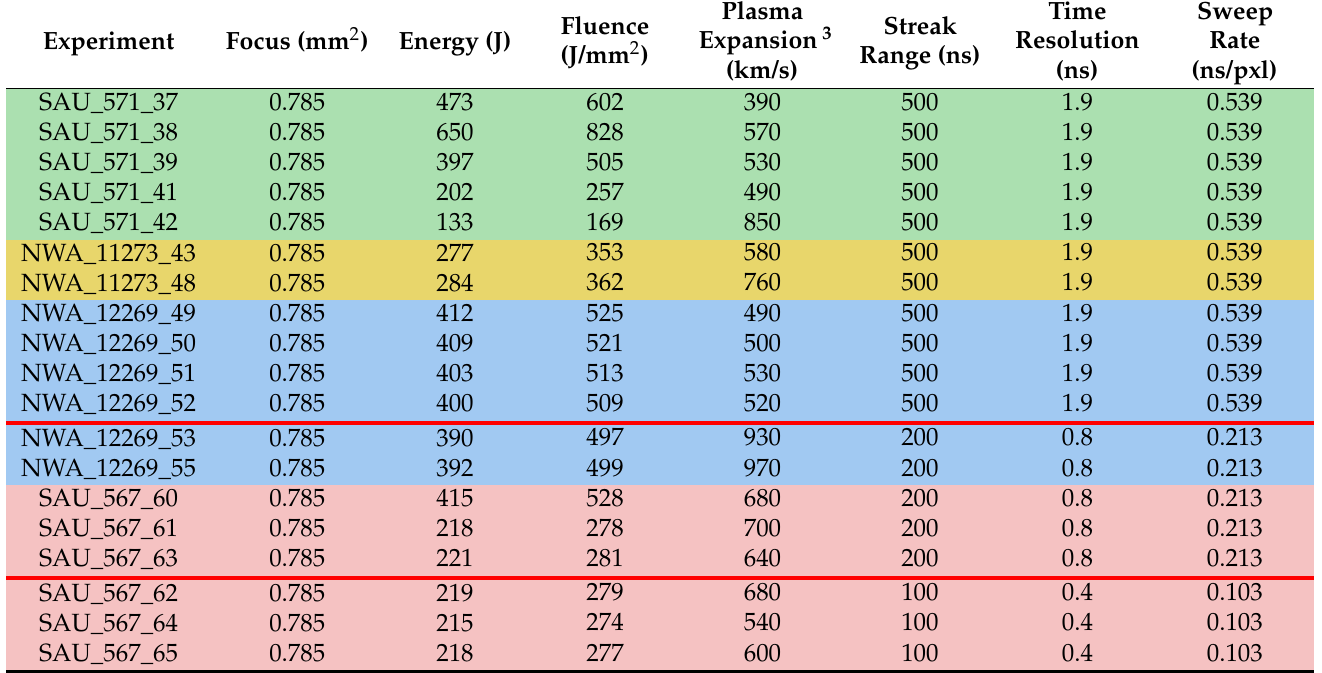
1 Colors represent individual meteorite samples. 2 Red lines mark a change in streak camera parameters. 3 The uncertainty of the results obtained with streak camera is <10%.